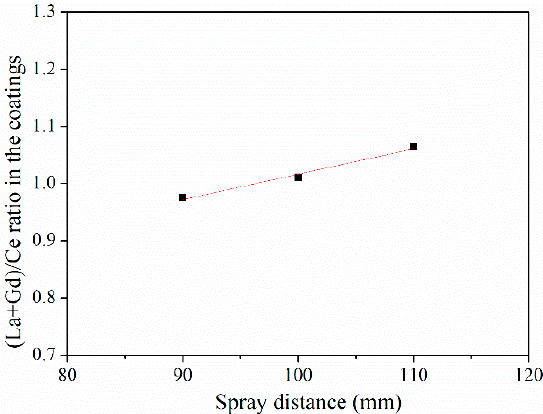
Figure 4. (La + Gd)/Ce ratio in the as-sprayed coatings versus spray distance.